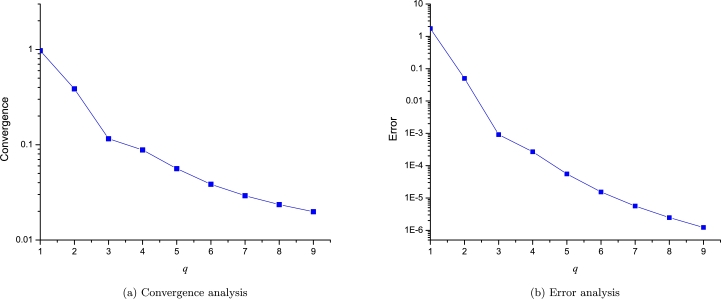
Convergence and error analysis for problem with a discontinuity (38).